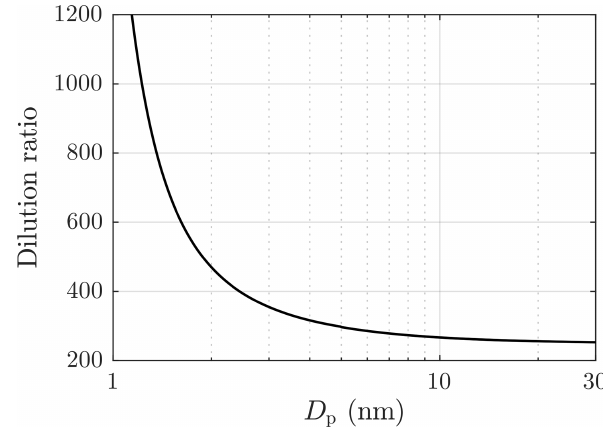
Figure 2. The detection efficiencies of the PSM, with five different saturator flow rates used in this experiment, and of the condensa- tion particle counters (CPCs). The curves are exponential fittings based on the detection efficiencies reported by the manufacturers of the devices, excluding the CPC 3776 curve, which is based on the efficiency measured by Mordas et al. (2008).